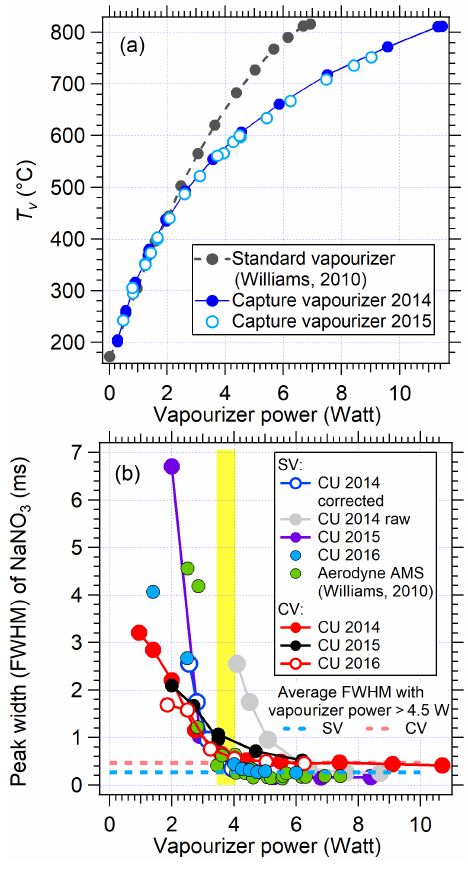
Figure 2. (a) Relationship between vapourizer temperature ( T v as reported by the attached thermocouple) and vapourizer power. (b) Peak width of measured size distributions of 300nm NaNO 3 particles as a function vapourizer power. In (b) , the 2014 curve raw (grey trace) between peak width and vapourizer power in the SV indicated that the vapourizer power reading in that AMS system was inaccurate during those tests (see main text). Therefore, a cor- rection (Corrected vapourizer power = 0.6 × displayed vapourizer power + 0.1), which was obtained by matching the CU 2014 curve to the others from SV, was applied. The yellow background shows the range of vapourizer power between 3.6 and 4W, where a transi- tion in the detected peak width occurs in both vapourizers. The blue and pink dashed lines are the average values of peak width from CU 2016 curves of SV and CV (respectively) when vapourizer power is above